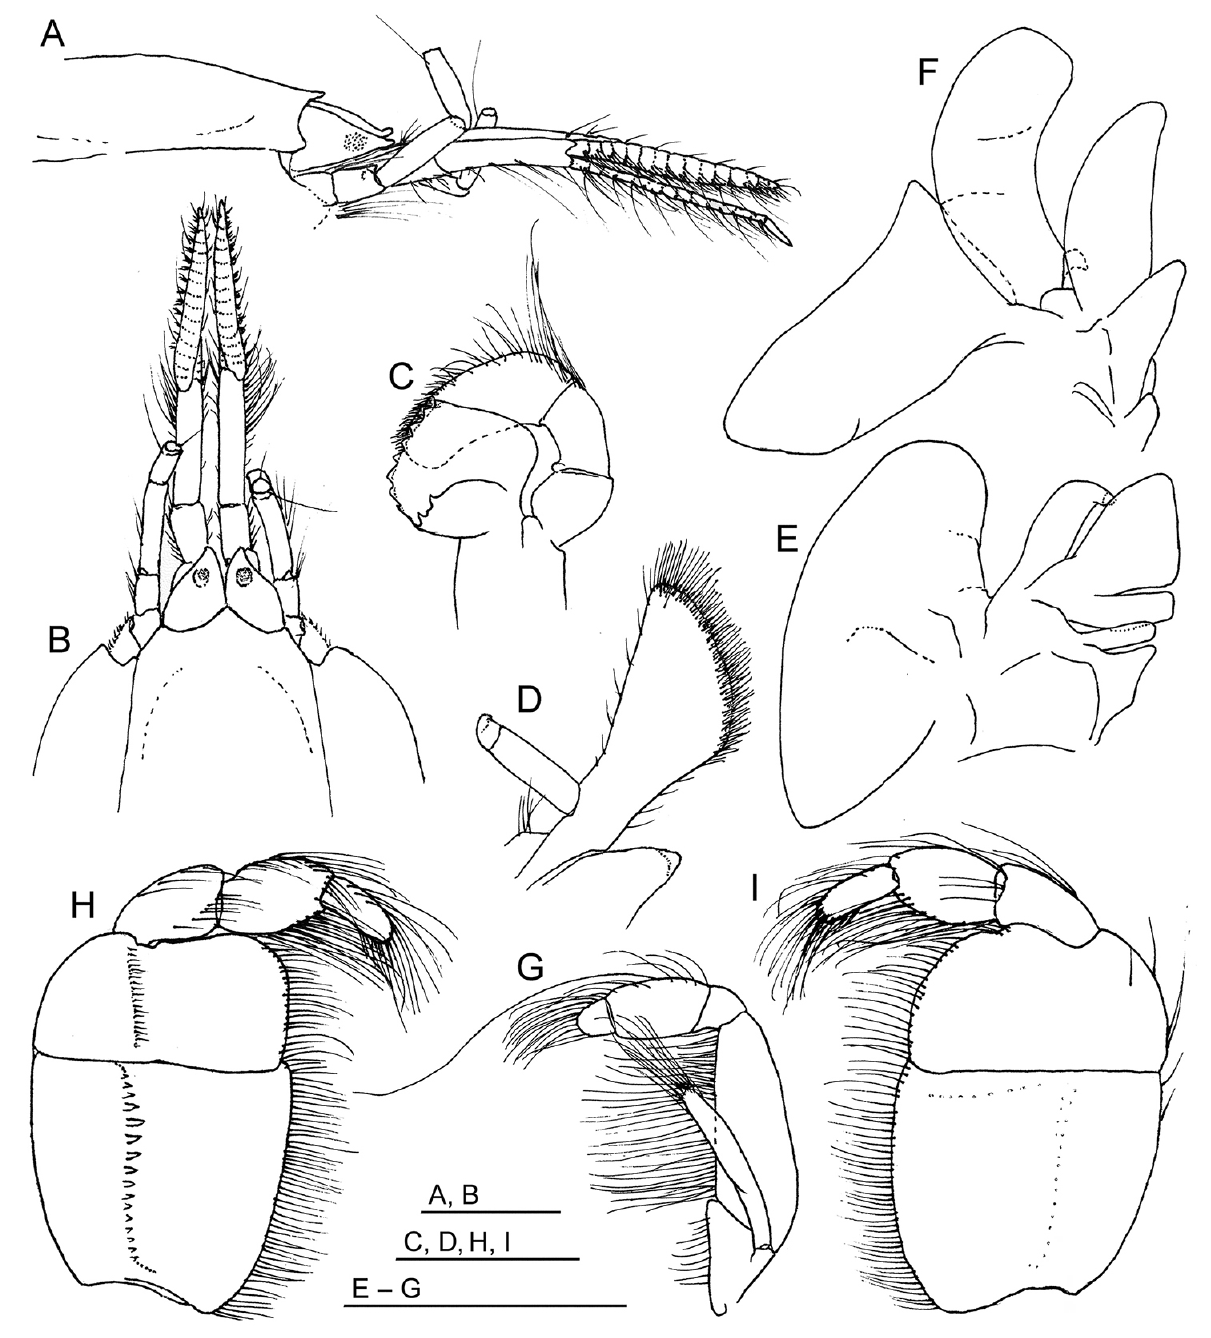
Figure 4. Gilvossius fredericqae n. sp., female holotype, pocl 4.0 mm, northwestern Gulf of Mexico, off Texas, 98 m depth (USNM 1607374 = ULLZ 17894): A , B , anterior carapace, eyes, and peduncles, lateral and dorsal; C , right mandible, internal; D , right first maxilla, external; E , right second maxilla without setae, external; F , right first maxilliped without setae, external; G , right second maxilliped, external; H, I , right third maxilliped, internal and external. Scale bars = 1.0 mm ( A, B, E–G ), 0.5 mm ( C, D ).